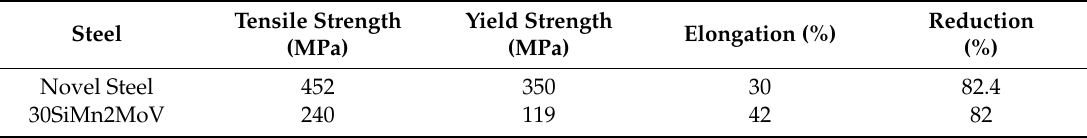
Figure 4. Monotonic tensile stress-strain curves of the novel steel and 30SiMn2MoV steel at 700 ◦ C. Table 2. The mechanical properties of the novel steel and 30SiMn2MoV steel at 700 ◦